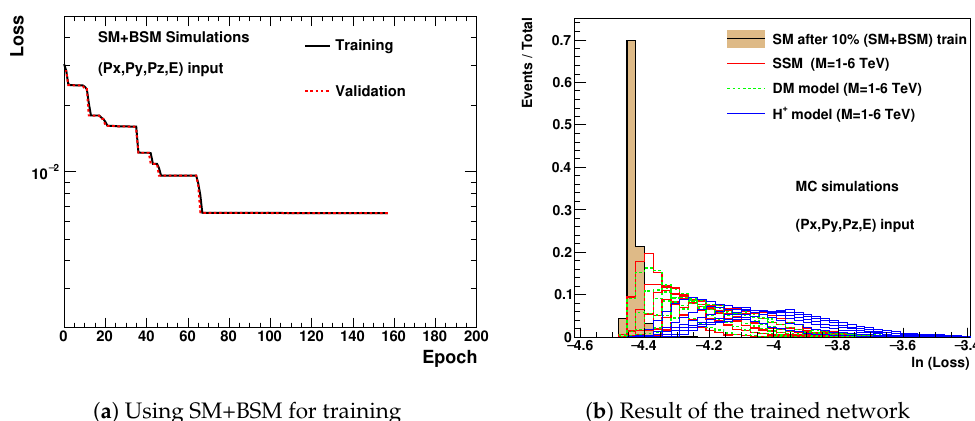
Figure 4. The loss values as a function of epochs using arrays with four-momenta using training of the autoencoder. The BSM models used for training had 1000 events for each mass point in the range 1–6 TeV. The right-hand figure shows the results of the trained network applied to the SM and BSM models. The BSM models are shown for Z (cid:48) / W (cid:48) heavy bosons in the mass range 1–6 TeV (shown with different lines of the same color).